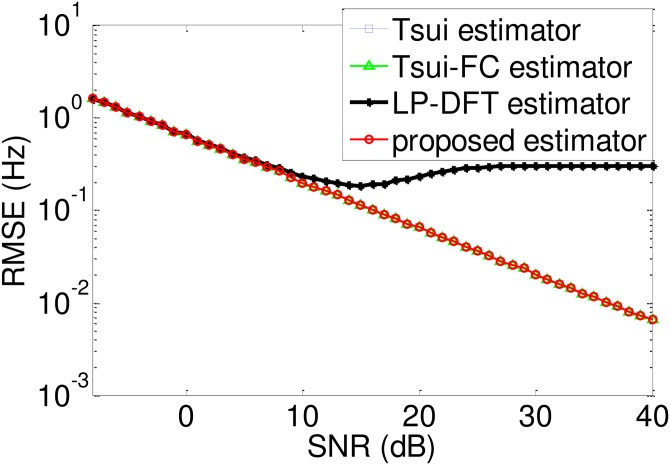
RMSE comparison among different CRT-based estimators.